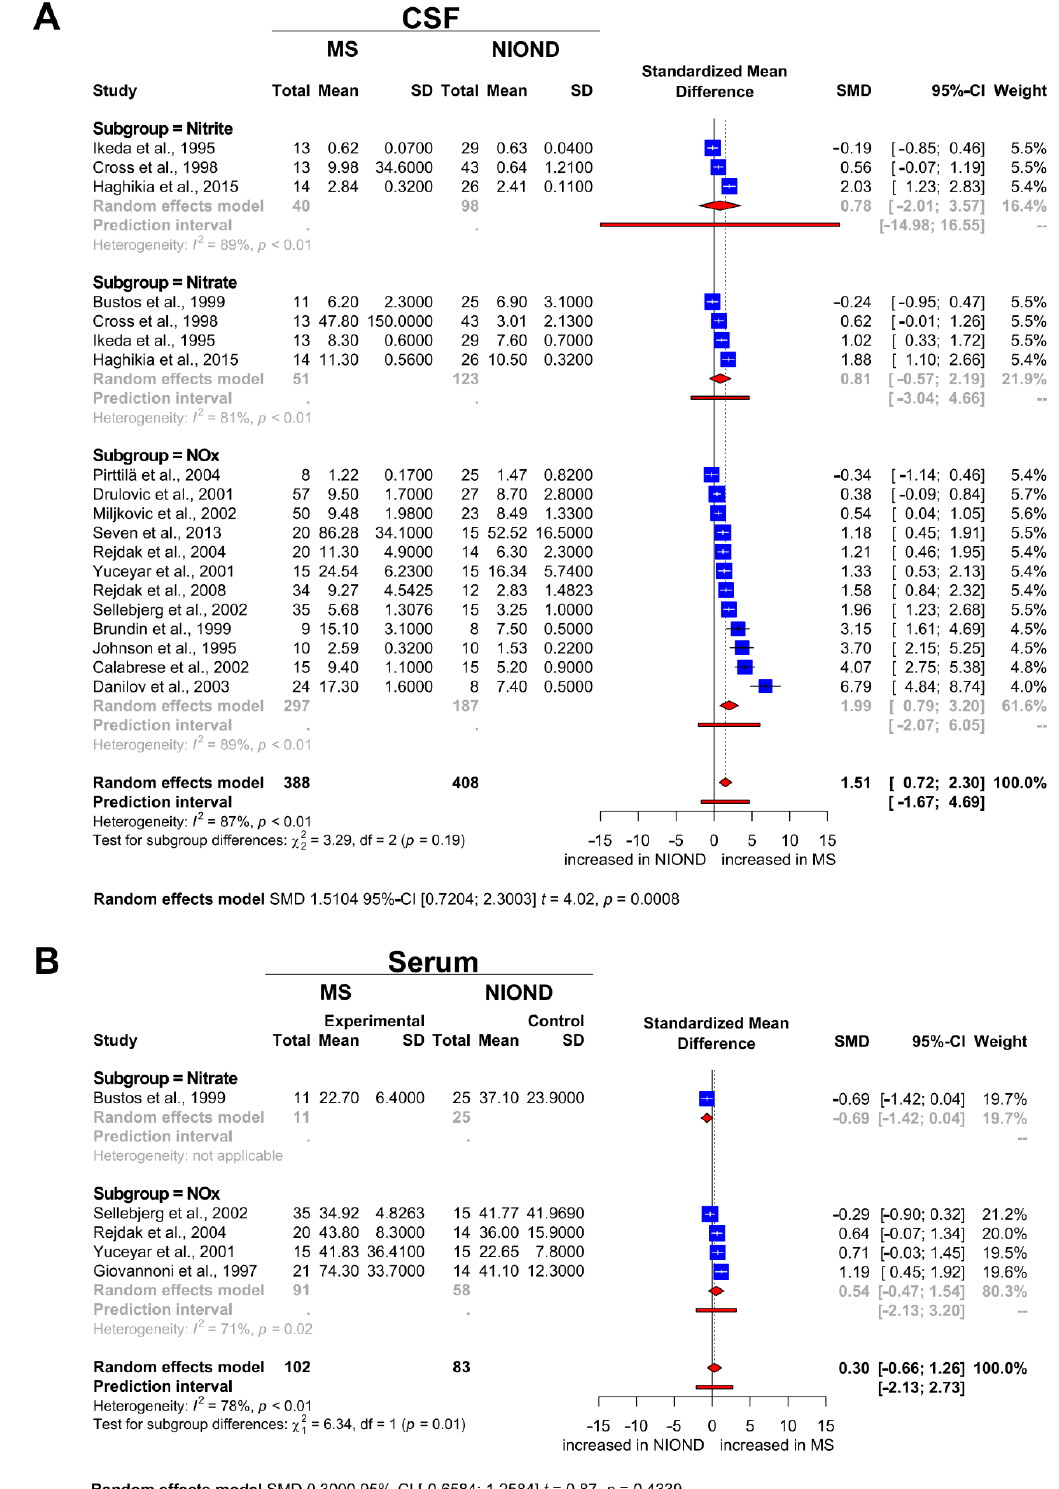
Figure 2. Forest plots displaying the meta-analysis for markers of nitrosative stress in ( A ) the CSF and ( B ) the serum compartment for MS vs. NIOND, respectively. The dashed vertical line indicates the overall effect, while the solid line indicates the null effect (SMD = 0). Abbreviations: CSF = cerebrospinal fluid, NIOND = noninflammatory other neurological disease, NOx = sum of nitrite and nitrate levels, MS = multiple sclerosis, SD = standard deviation, SMD = standardized mean difference.